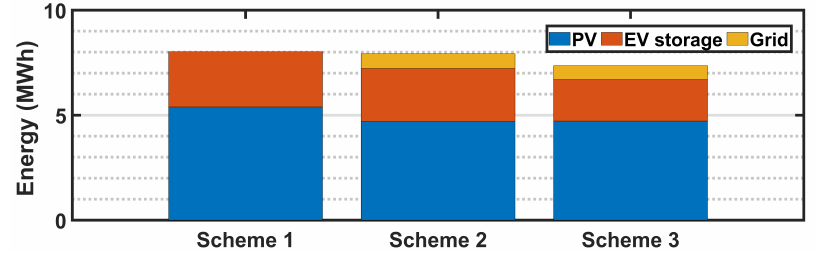
Figure 13. Comparative power utilization.